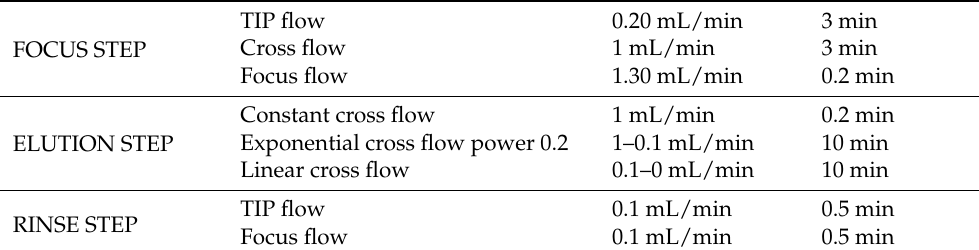
Table 1. Parameters for AF4 method—Detector flow was kept at 0.5